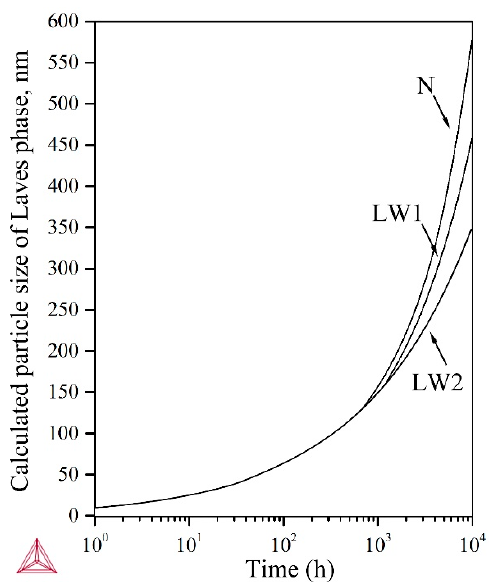
Figure 16. Effect of W content on precipitation kinetic of Laves phase in 9Cr3W3Co steel under 650 °C simulated by Thermo-Calc.